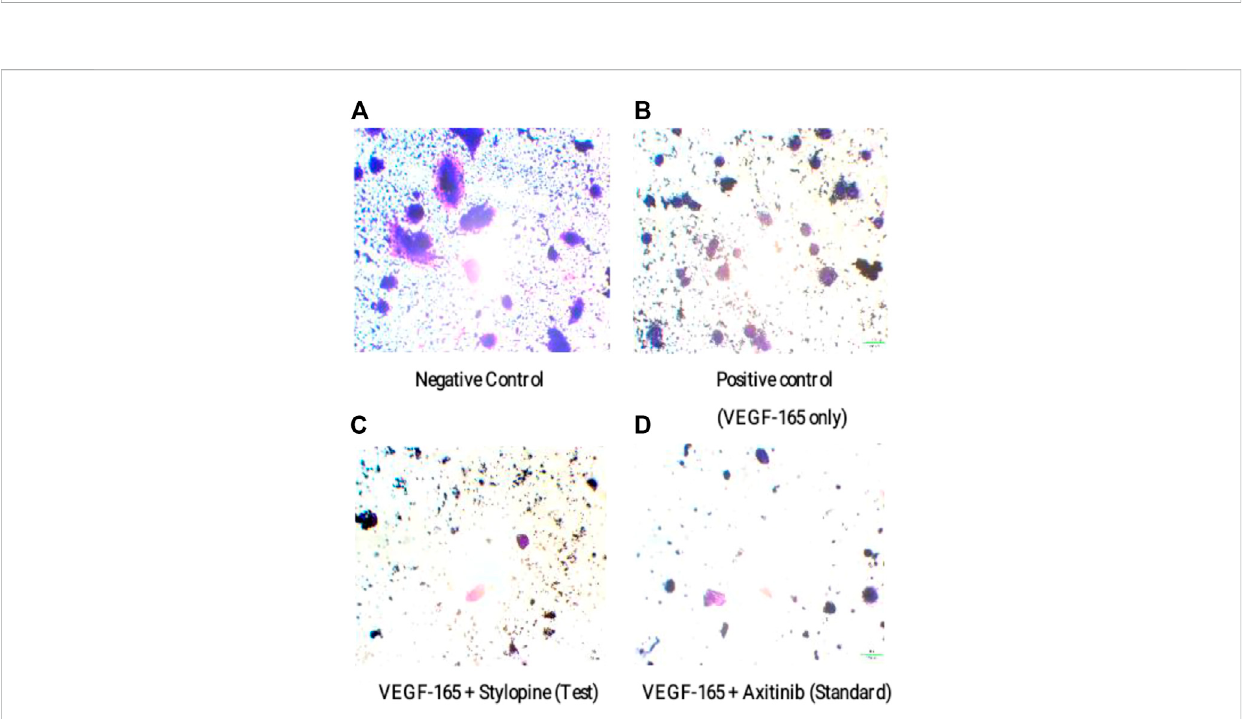
RepresentationofmigratedMG-63cellsusinganinvertedmicroscopebasedontranswellmigrationassay. (A) negativecontrol, (B) cellstreatedwith VEGF-165 only, (C) cells treated with VEGF-165 with stylopine, and (D) cells treated with